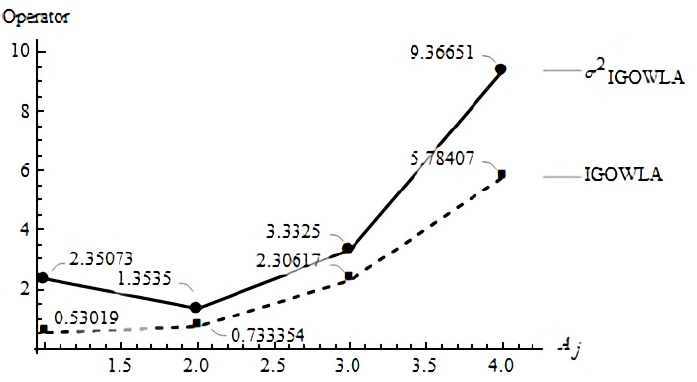
Figure 6. IGOWLA and σ 2 IGOWLA operators evaluating the arguments in Example